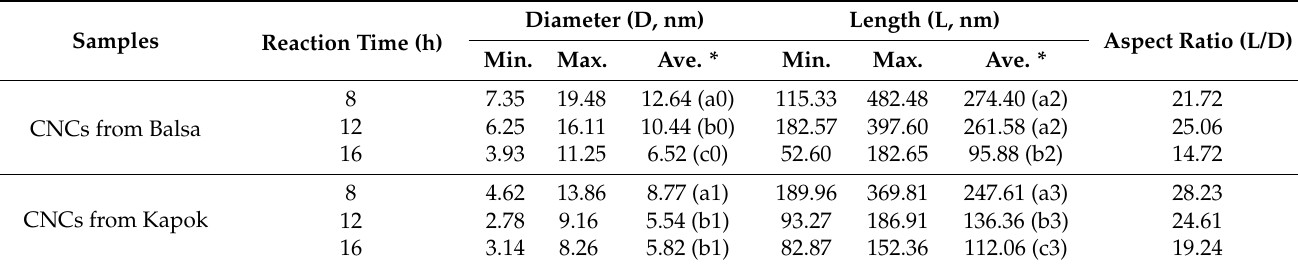
Table 1. Balsa and kapok fiber CNC size